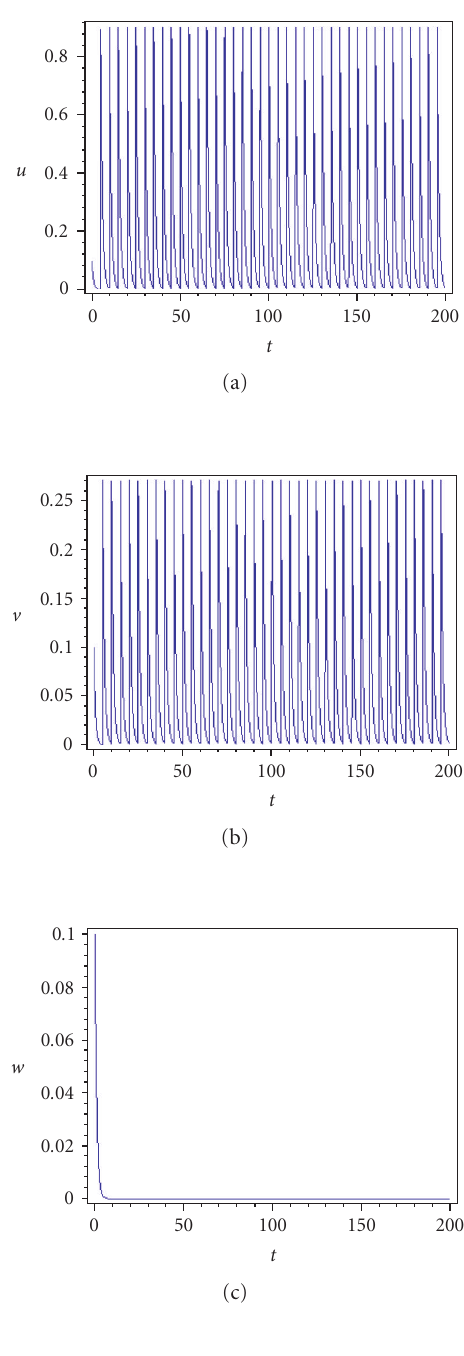
Figure 5.1. Time series of the system (3.1) with pulse, A = 5 / 9, p = 0 . 54, B = 20 / 9, Q = 0 . 9, and T =